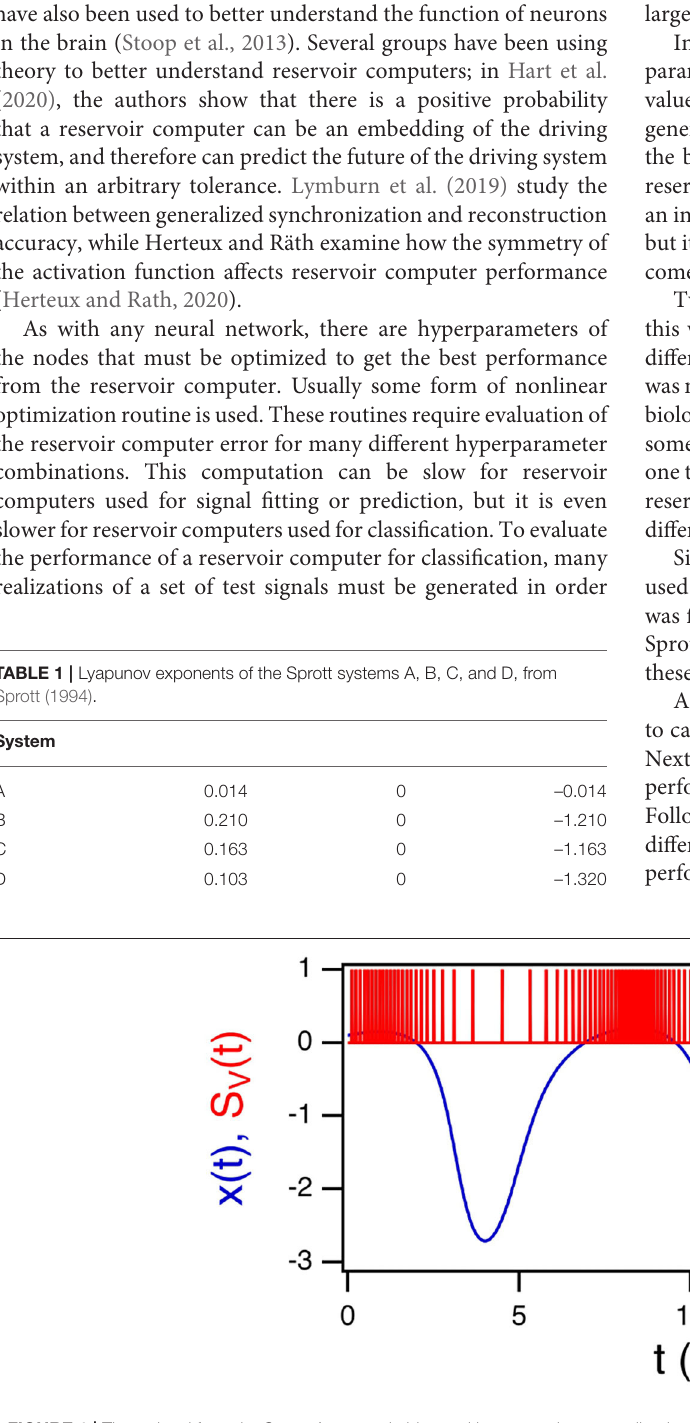
FIGURE 1 | The x signal from the Sprott A system in blue and its conversion to a spike time series S V ( t ) in